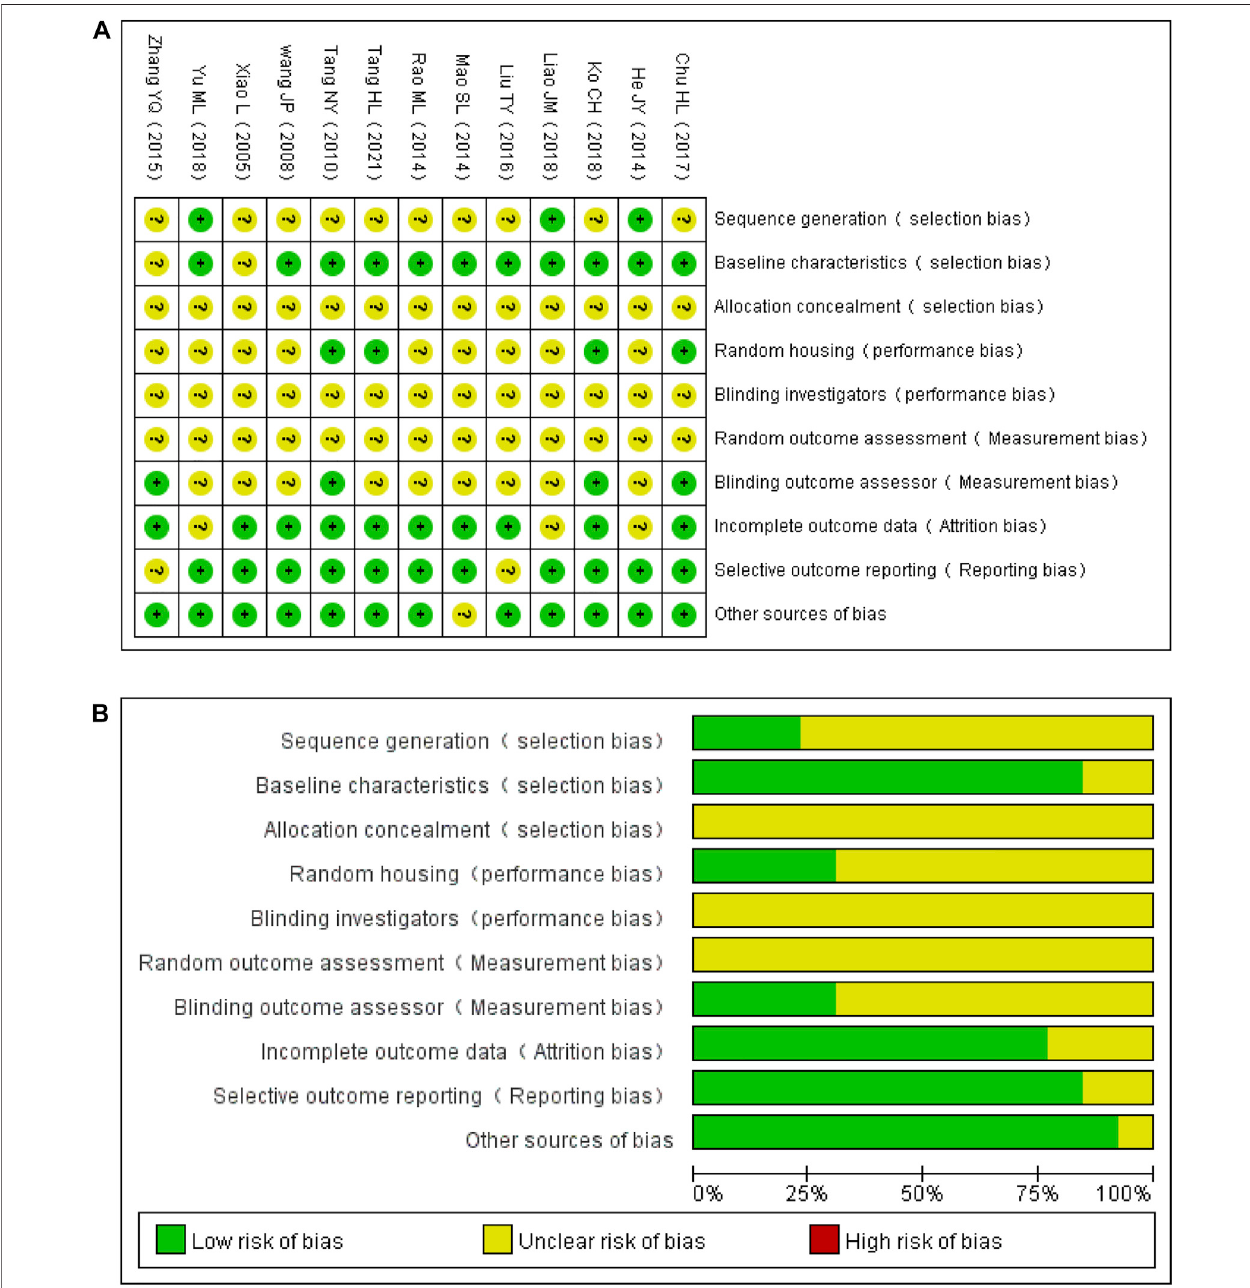
Frontiers in Pharmacology |